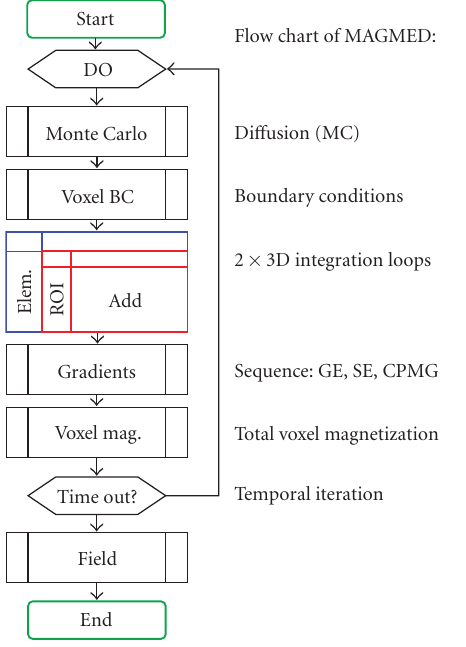
Figure 1: Flow chart of the model. It consists of the dipole model and a Monte Carlo time-step procedure. The inner of the two 3D loops is substituted in the present work by a known field distribu- tion for the element (i.e., the field distribution for an infinite